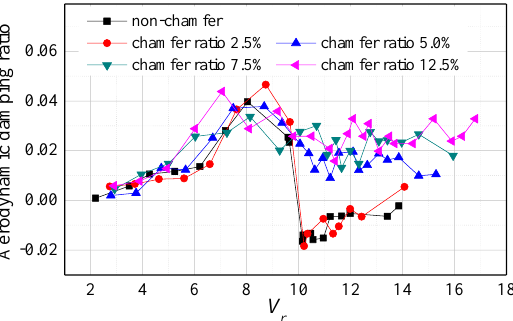
Figure 9. Aerodynamic damping ratio of the aeroelastic model with different chamfer ratios.